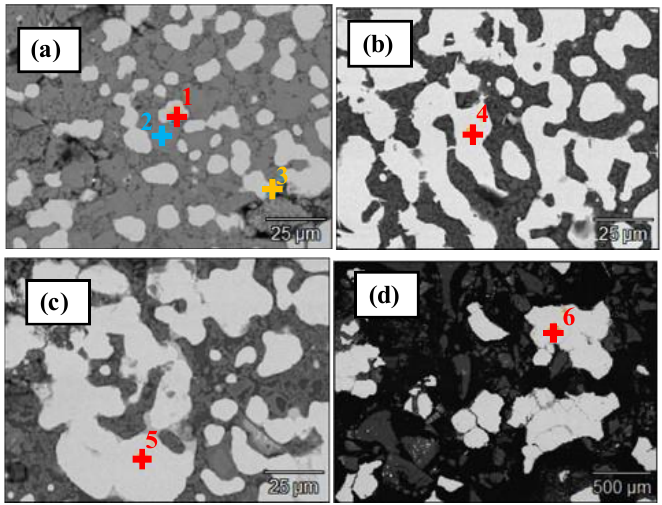
Figure 12. SEM images of ferronickel particles from different reduction temperature co-reduction products: ( a ) 1100 °C; ( b ) 1200 °C; ( c ) 1300 °C; ( d ) 1400 °C. Table 5. EDS analysis results of reduction product for areas in Figure 12.